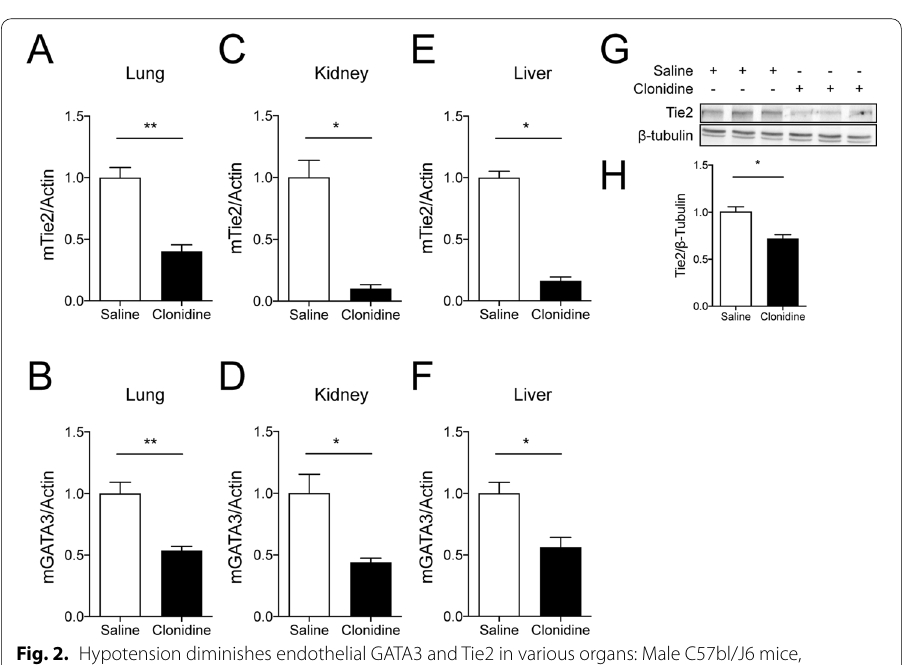
Fig. 2. Hypotension diminishes endothelial GATA3 and Tie2 in various organs: Male C57bl/J6 mice, 10–12 weeks of age, were challenged with either saline or clonidine to induce hypotension. A–B Lung (** p < 0.01, n 7 per group) ( C – D ) kidney (*p < 0.05, n 5 per group) and ( E – F ) liver were assessed for Tie2 = = and GATA3 mRNA level (* p < 0.05, n 5 per group). G Representative Immunoblot of whole-lung lysates for = Tie2 and β-tubulin expression and ( H ) densitometric quantification of blots (* p < 0.05, n 5 per =